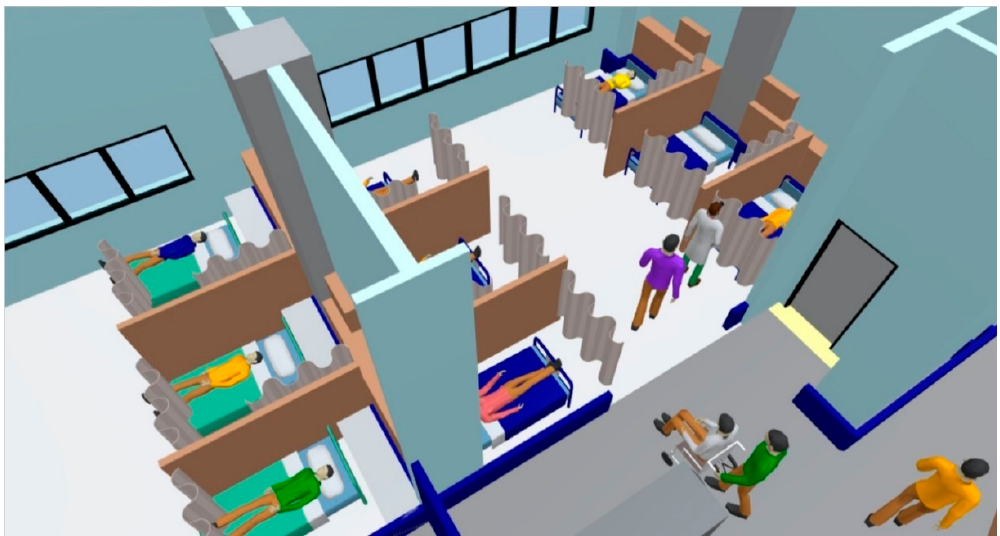
Figure 7. The simulation results for the regular process with pedestrian density.